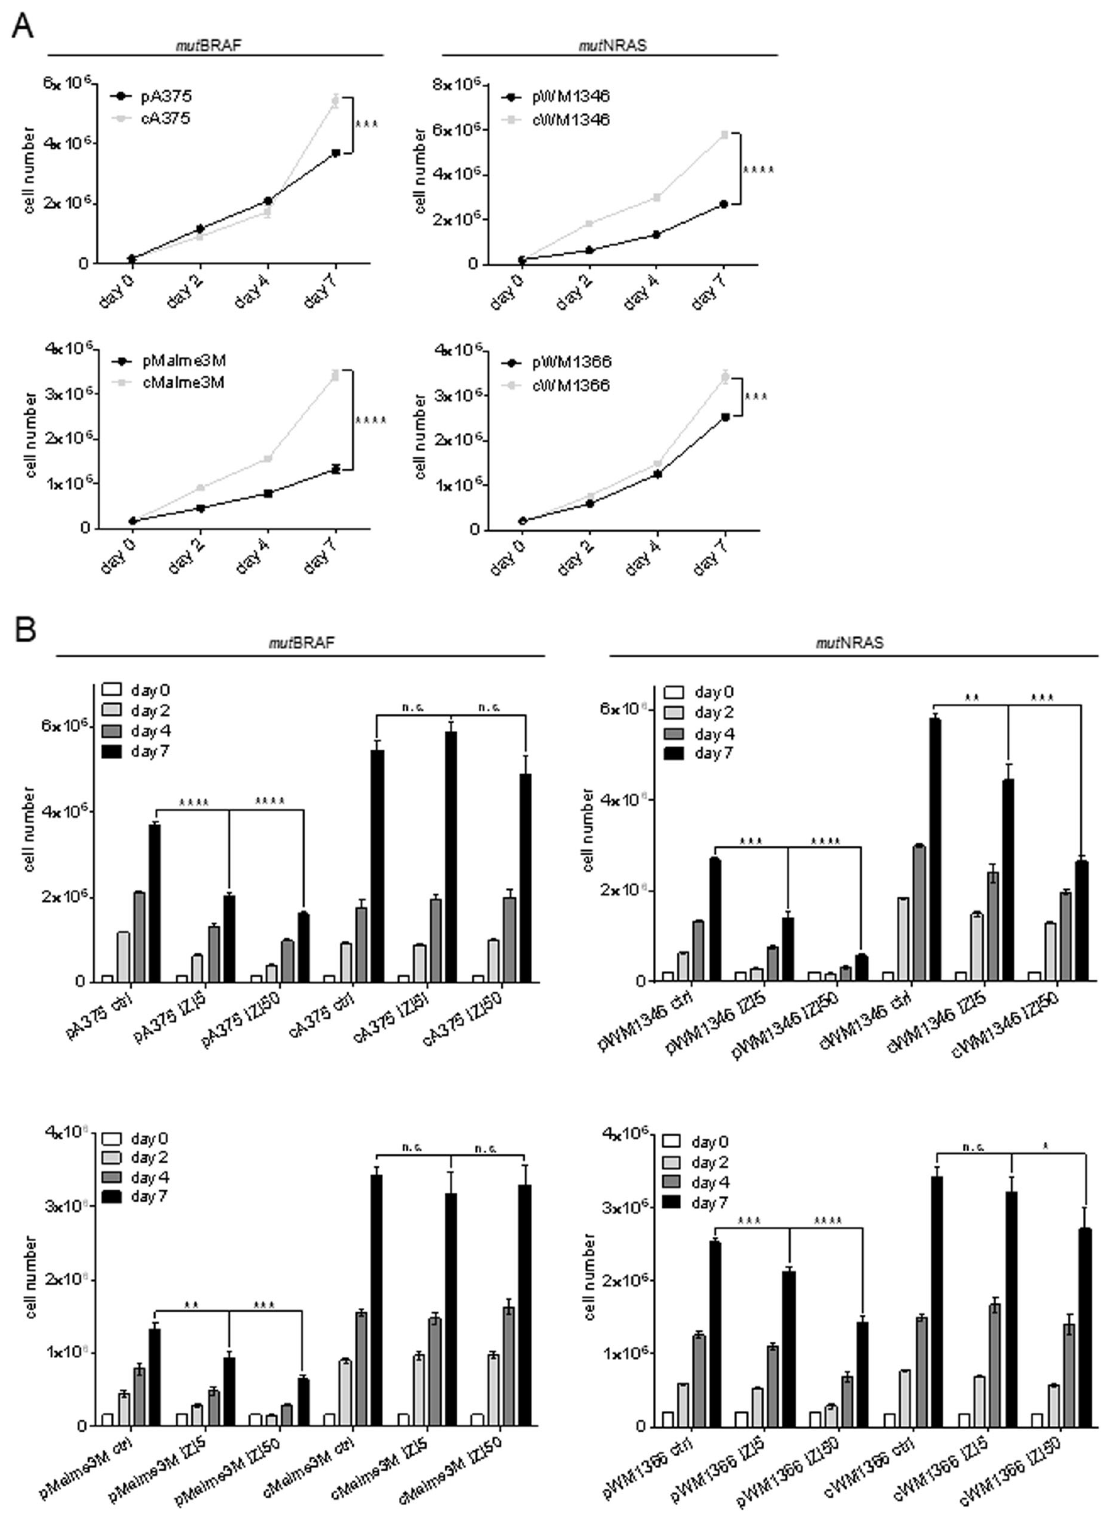
Fig. 2 Conditioning to IZI5 enhances proliferation of mut BRAF and mut NRAS MM cells. A Proliferation of unstimulated parental (p) versus IZI5-conditioned (c, 5 ng/ml) MM cells was quanti fi ed at the indicated time points (*** p ≤ 0.001; **** p ≤ 0.0001). B Parental (p) and IZI5- conditioned (c) cells were left untreated or stimulated with IZI5 and IZI50, respectively, every other day. Proliferation of cells was quanti fi ed at the indicated time points ( n = 3: * p ≤ 0.05; ** p ≤ 0.01; *** p ≤ 0.001; **** p ≤ 0.0001; n.s. = not signi fi cant).